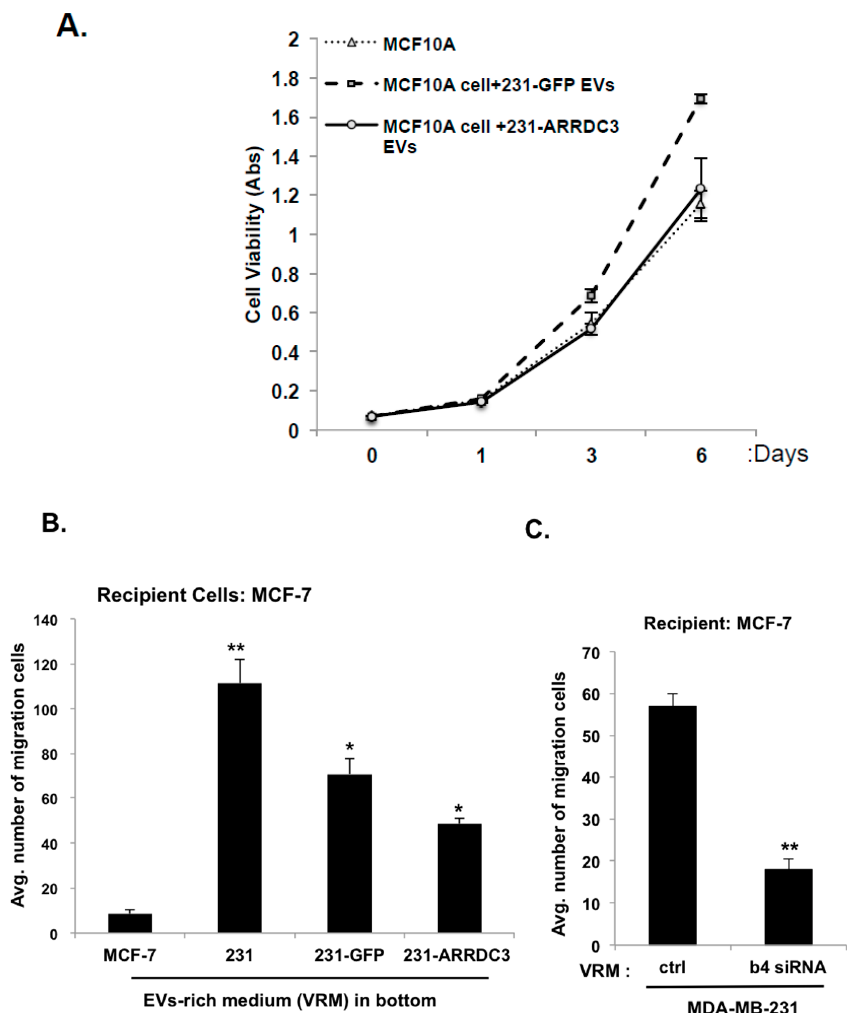
Figure 7. ARRDC3 reduces tumorigenic and invasive potentials of TNBC cell derived EVs. ( A ) MCF-10A cells were incubated with dil-labeled EVs derived from GFP-empty and GFP-ARRDC3 expressing MDA-MB-231 cells for the indicated times. Cell proliferation was measured by MTT assay. ( B ) MCF-7 cells were loaded into the upper chamber of a transwell. Medium containing rich EVs derived from the indicated cells (VRM; EVs rich medium) was added into the lower chamber. After 48 h incubation, the migration was quantified by counting the migrated cells to the bottom side of chamber per square milliliter using bright-field optics. ( C ) Same amounts of EVs from each MAD-MB-231 cells expressing control or ITG β 4 siRNA were added to medium (VRM). The ability of MCF-7 cells to migrate under the VRM condition was measured using transwell cell motility assay. Representative results were obtained from three independent experiments. Column, mean from three independent experiments; Bars, SD. * p ≤ 0.005. ** p ≤ 0.01.